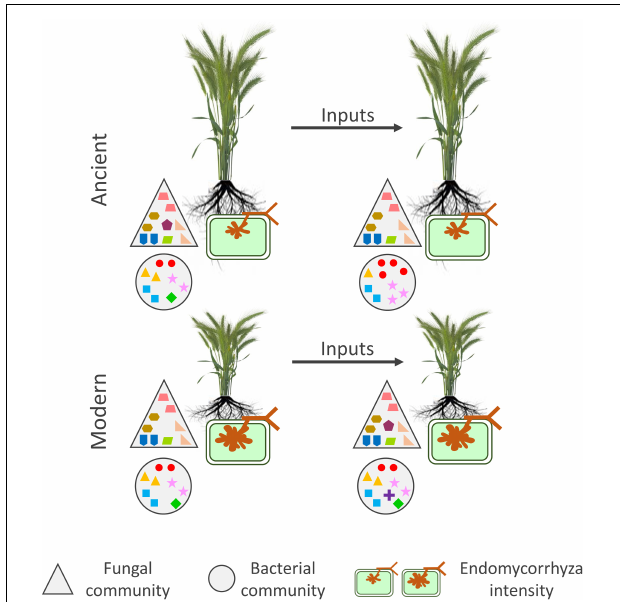
FIGURE 6 | Summary picture of the main effects detected by PERMANOVA on the alpha-diversity indices and mycorrhizal colonization parameters. The figure depicts ancient (tall plants) and modern (short plants) rhizosphere microbiota with and without inputs. The big triangles and circles depict the fungal and bacterial communities, respectively. The mycorrhiza is depicted as a green cell with an arbuscular structure inside. The symbols inside the big triangles and circles represent OTUs. PERMANOVA results are shown in Table 2 . Only results from G, E, and G x E are shown. For the fungal community, input addition led to slight reduction in estimated richness for the ancient varieties and slight increase for the modern varieties. For the bacterial community, inputs reduced the richness and evenness for the ancient varieties but led to slight increase in richness for the modern varieties. For the mycorrhiza, the modern varieties had more pronounced colonization than the ancient